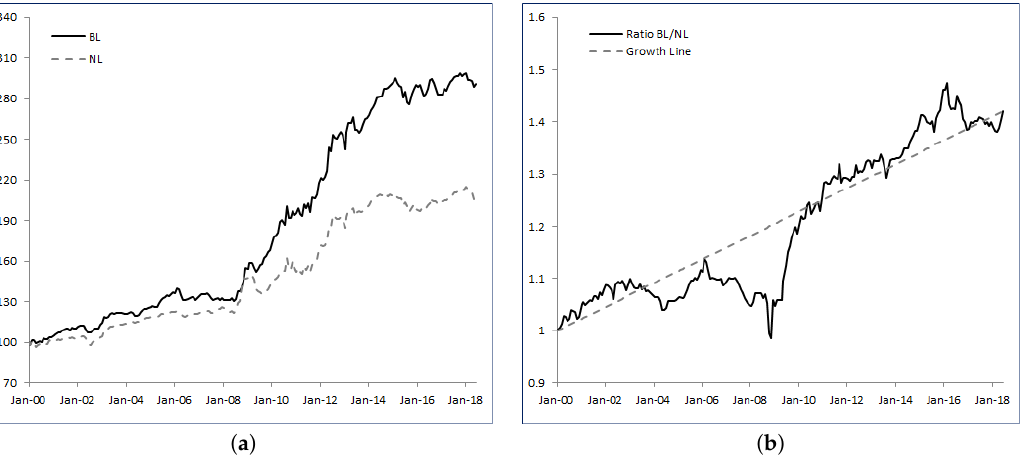
Figure 1. Historical values of the portfolios calculated with both w BL and w NL in the Base Case ( a ) and their ratio ( b